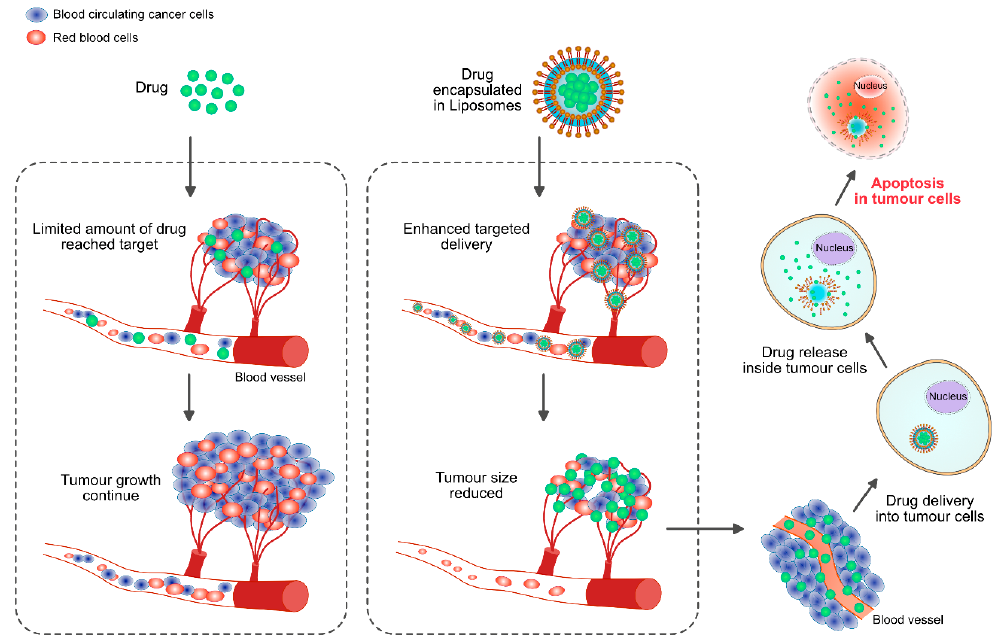
Figure 5. Drug delivery with and without Nanoparticles. Nanoparticle based targeted drug delivery enhanced the antitumor activity due to enhanced and sustained release of